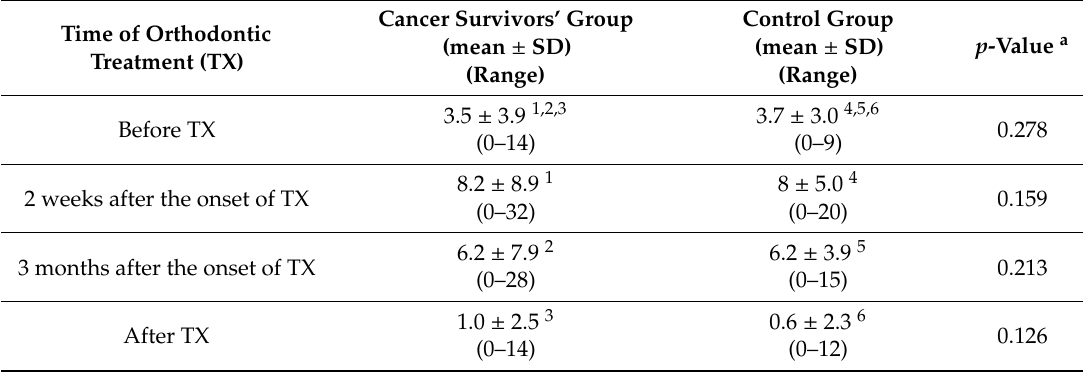
Table 4. The OHIP-14 mean total score in the cancer survivors’ and control groups before, during, and after orthodontic treatment.